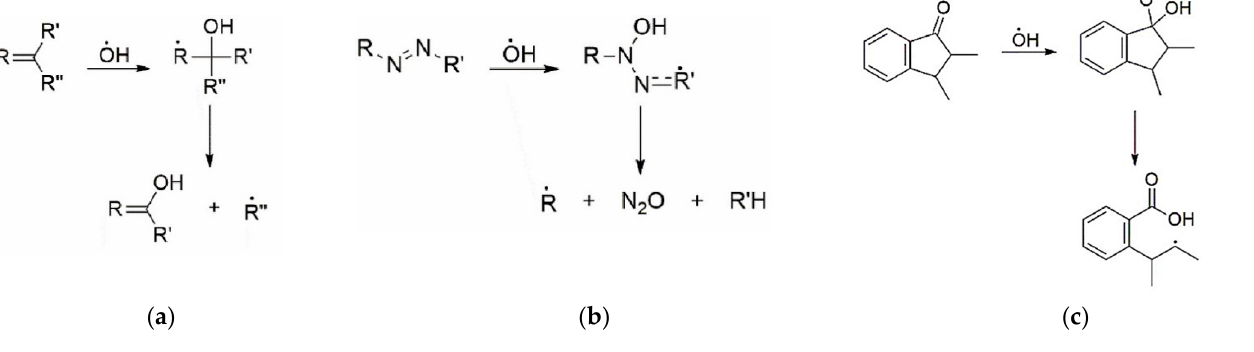
Figure 1. Interaction of OH ● with: aromatic units ( a ), azo bond ( b ), chromophores ( c ).